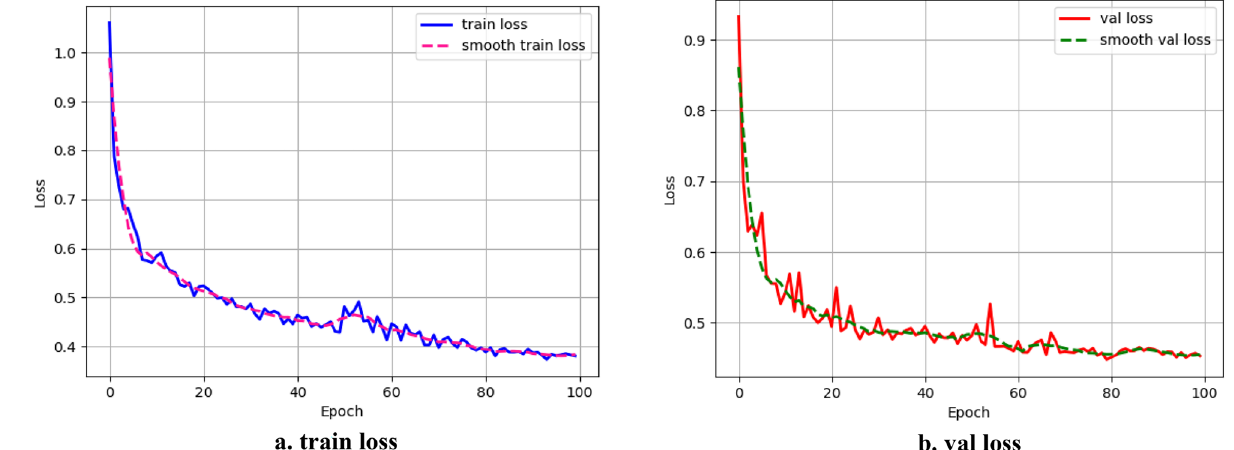
Figure 9. Schematic diagram of network model training process used in this paper.